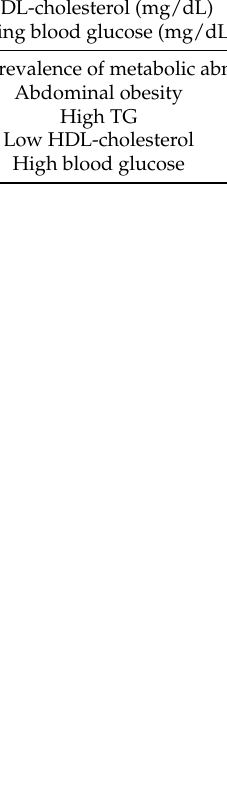
Table 3. Energy and nutrient intakes of